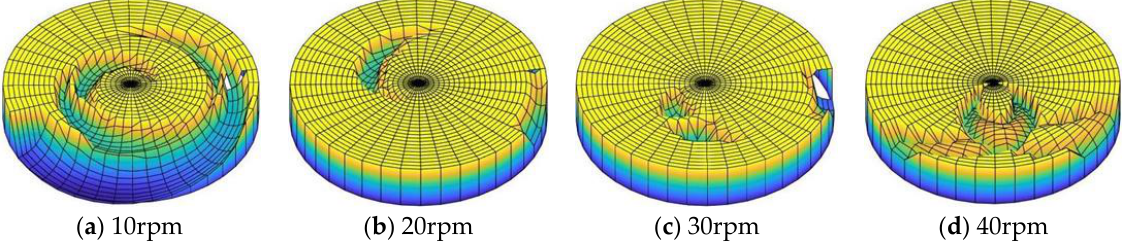
Figure 23. Scratch damage morphology on the workpiece surface with different polishing disc speeds.